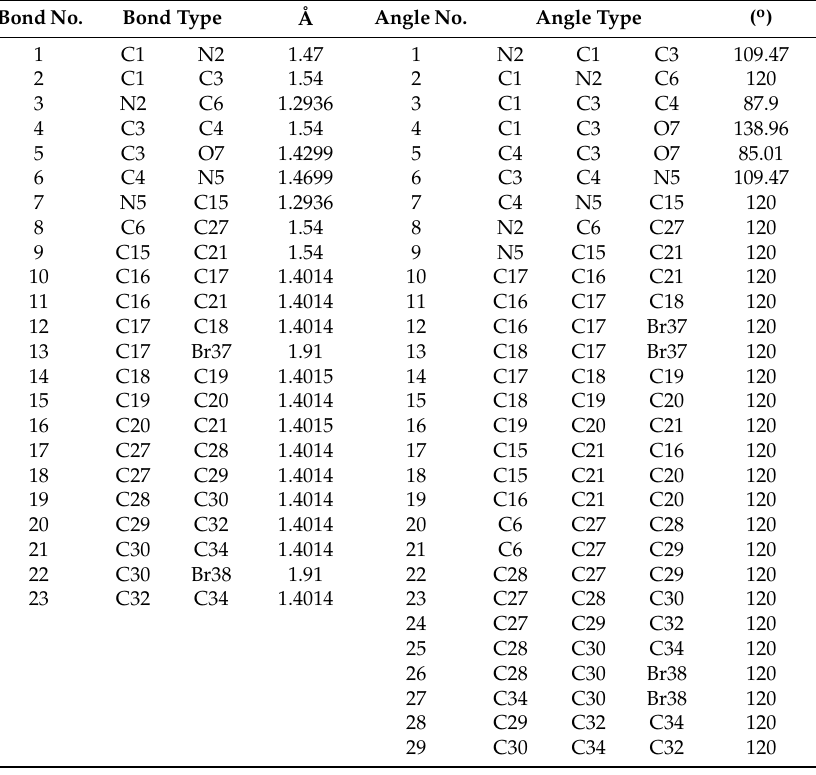
Table 1. Structure parameters (bond length and bond angle) of the compound. Table 1 . Structure parameters (bond length and bond angle) of the compound. Bond Bond No.